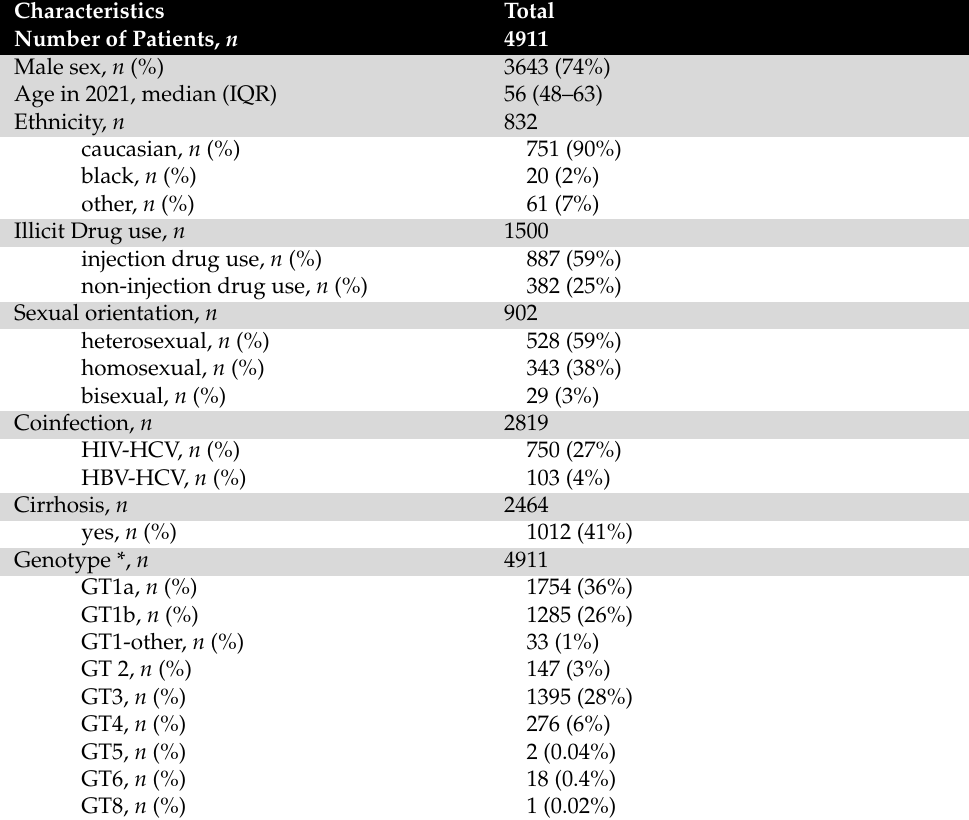
Table 1. SHARED cohort participant